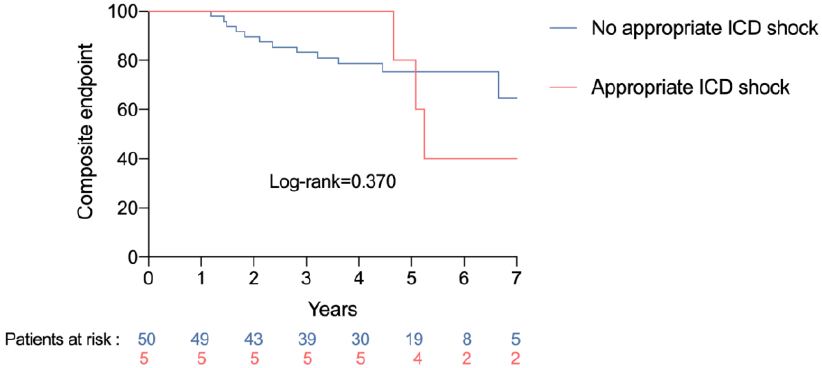
Figure 2. Occurrence of the composite endpoint according to appropriate device-delivered electric